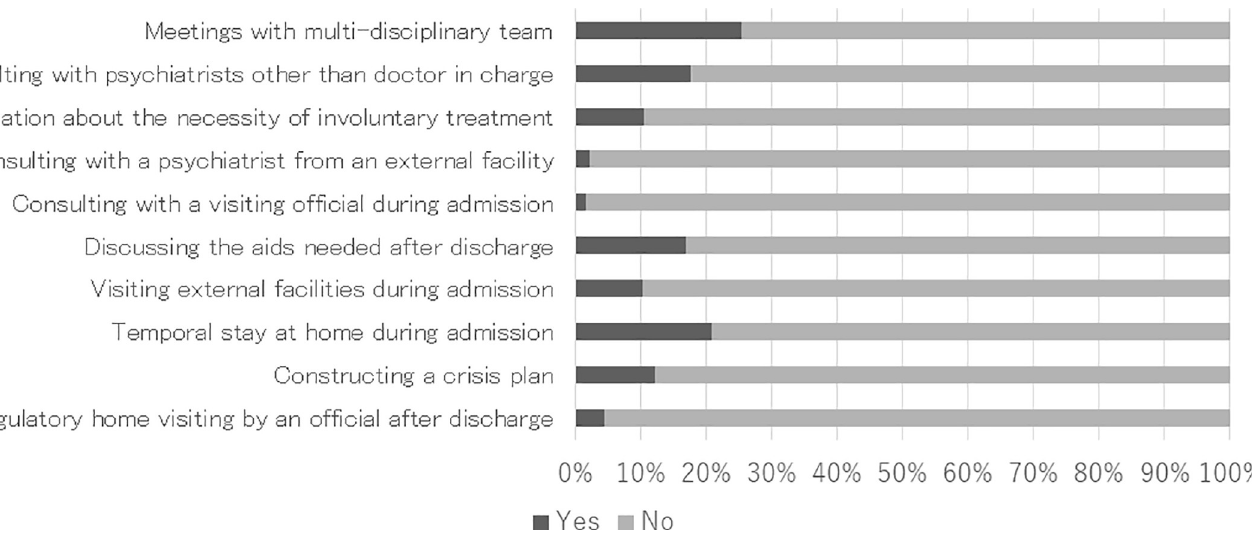
Fig 2. Treatment the participants had received during their most recent admission to a psychiatric ward.